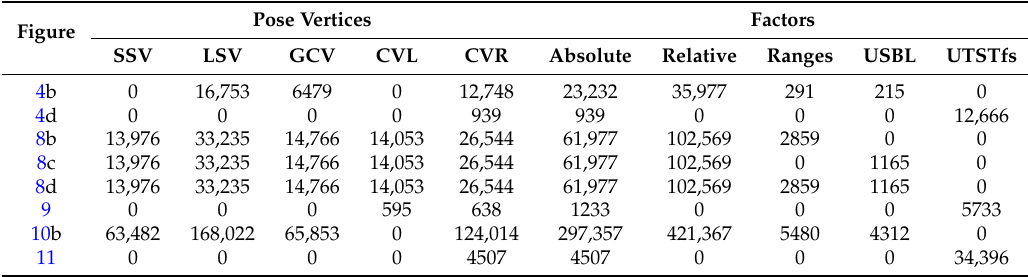
Table 1. Number of poses and factors for the graphs corresponding to the resulting trajectories and models shown in Section 6. Note that the UTSTfs column stands for up-to-scale transformation